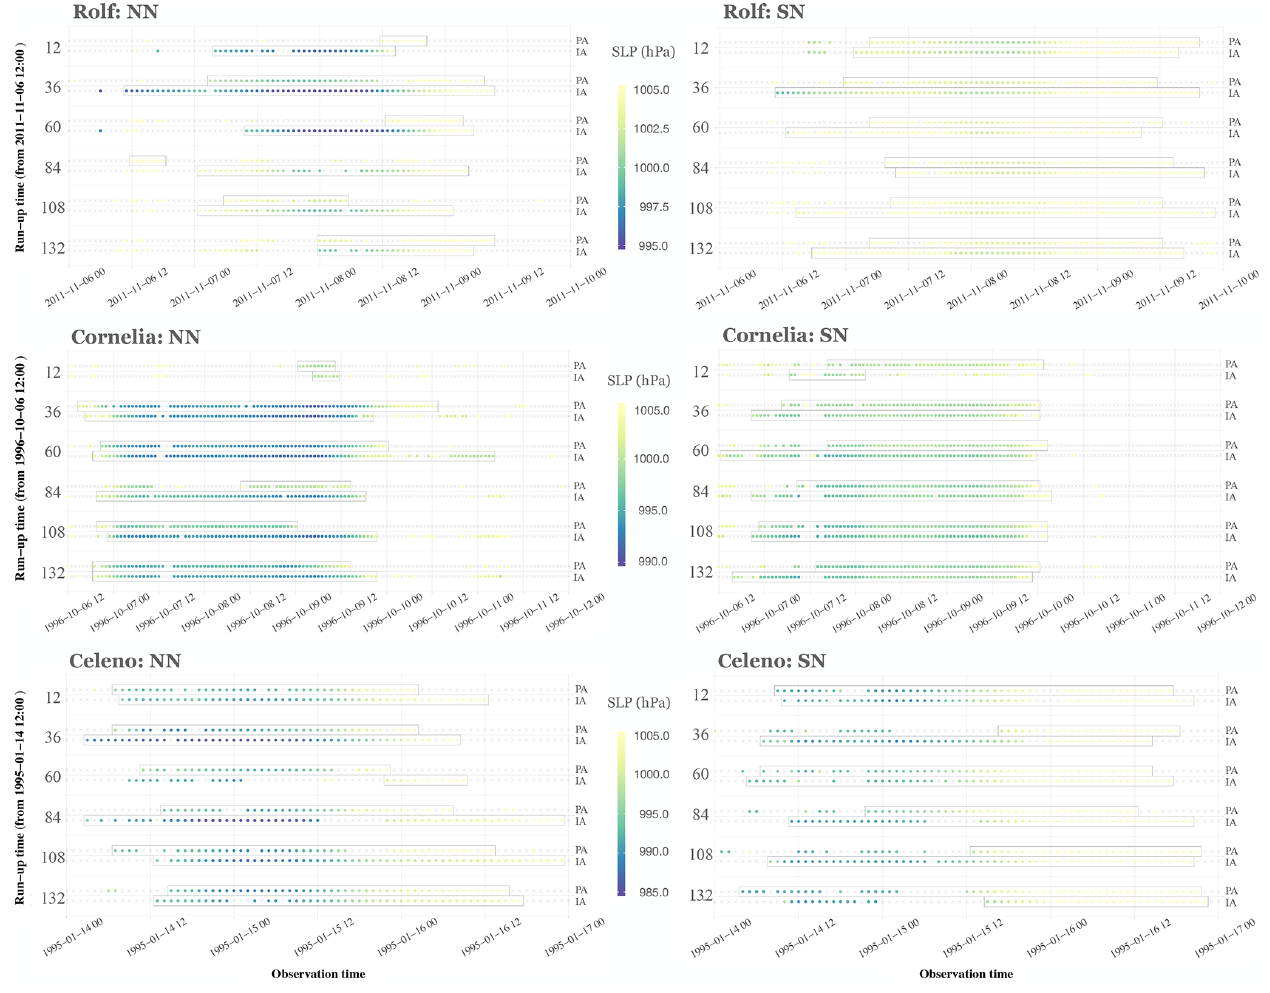
Figure 1. PA and IA pairs of simulations without (a, c, e) and with (b, d, f) spectral nudging represented for each run-up time of initialization for medicanes Rolf (a, b) , Cornelia (c, d) and Celeno (e, f) . A circle represents a time step where a medicane is found, its color being the SLP value for the medicane center. A grey cross is placed for the time steps in which no medicane is found. The grey frames include, for each simulation, the time steps inside the medicane’s more compact set of points, as described in Sect.